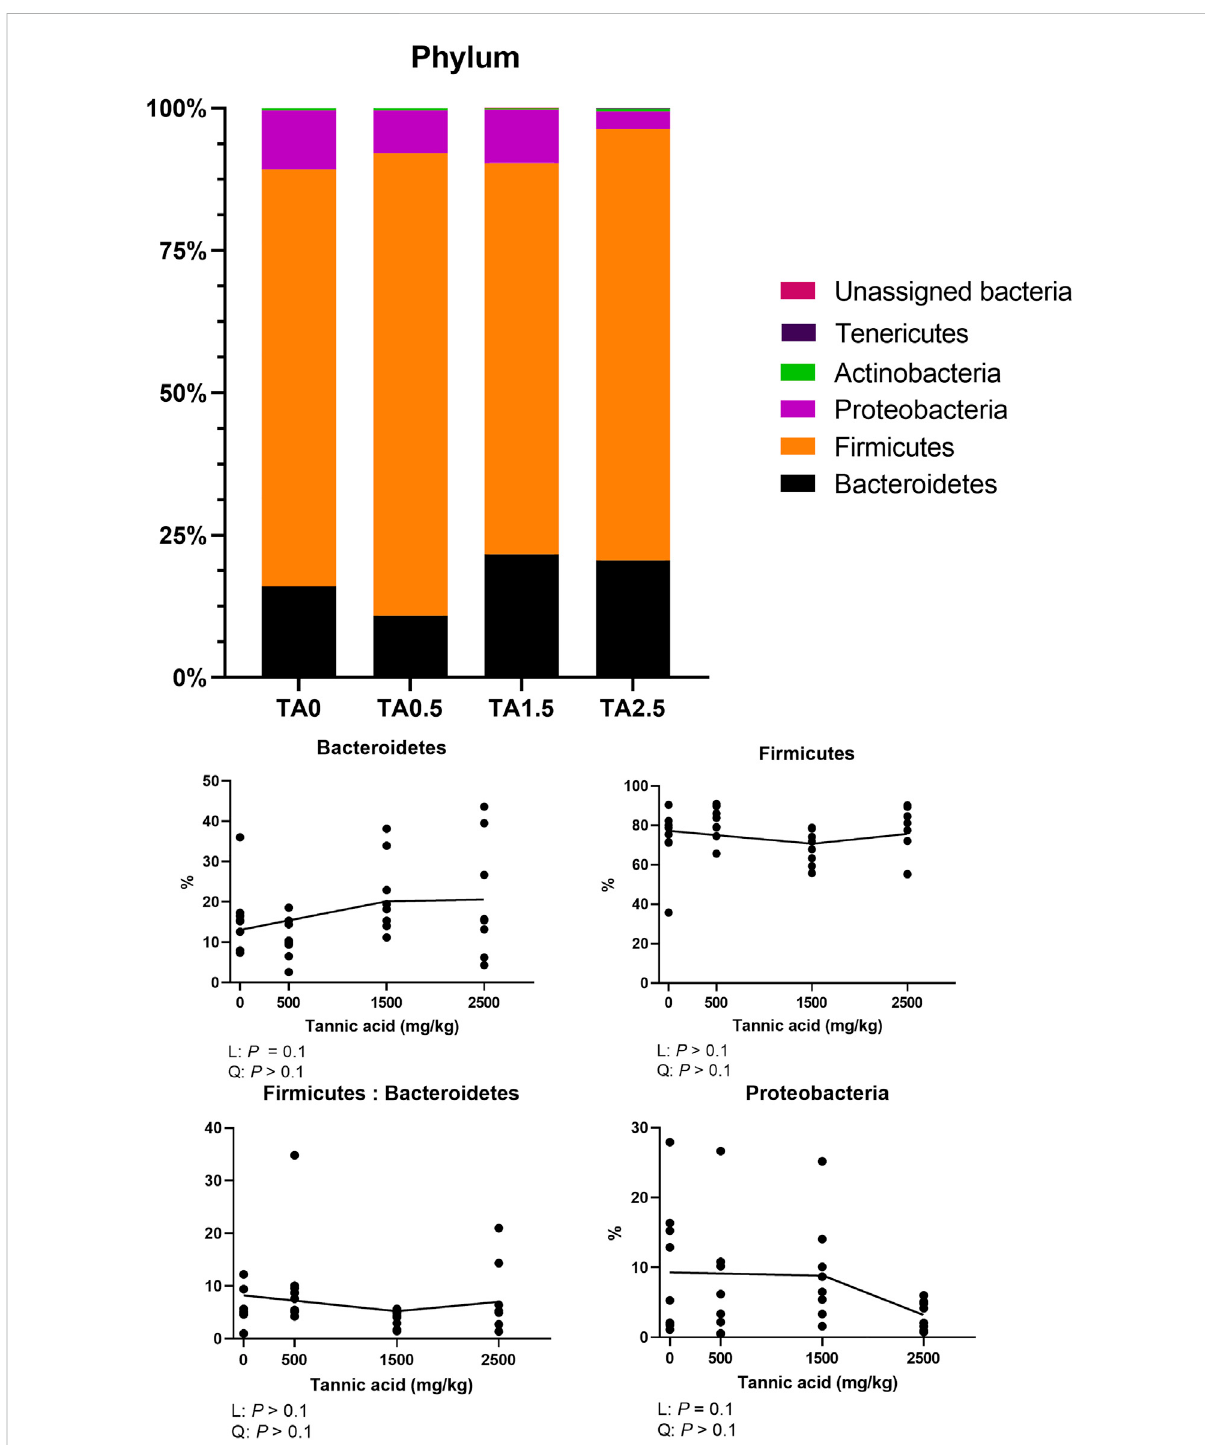
FIGURE 13 Phylum-level composition of the cecal microbial communities in broiler chickens fed different concentrations (0, 0.5, 1.5, and 2.5 g/kg) of tannic acid on D 21. Only phylum with signi fi cant differences and relatively high relative abundance were presented separately with statistical analyses. Thetreatmentgroups werecomparedusing one-way ANOVAfollowed bytheTukey ’ smultiplecomparison.Different superscriptsdifferat p < 0.05. Orthogonal polynomial contrasts analysis was conducted to seelinear pattern (L) and quadratic pattern (Q)among thetreatments. To calculatetheoptimaldosageoftannicacidinbroilers,segmentedlinear regressionwasconducted,and X0 (in fl ectionpoint)with p valuesforslope1 (lower than X0 ) and slope two higher X0) were